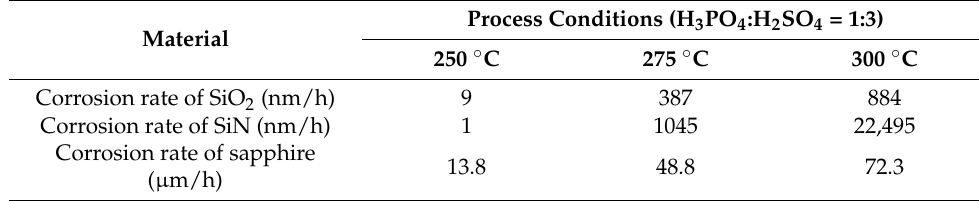
Table 6. Corrosion rate of different materials.